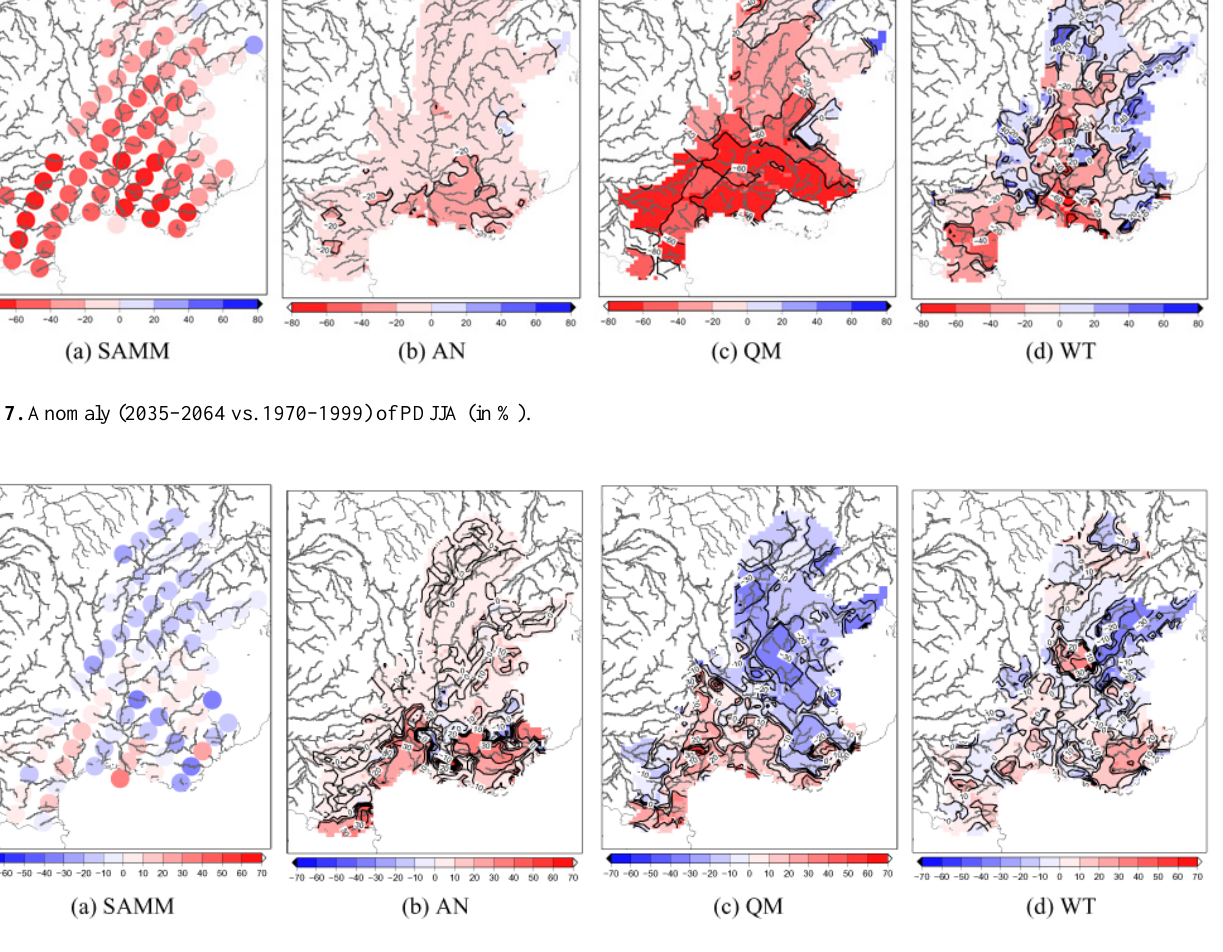
Fig. 8. Anomaly (2035–2064 vs. 1970–1999) of PXCDD (in